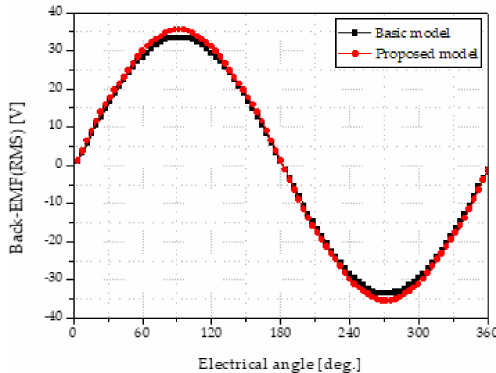
Figure 10. Characteristics of the back EMF waveform.